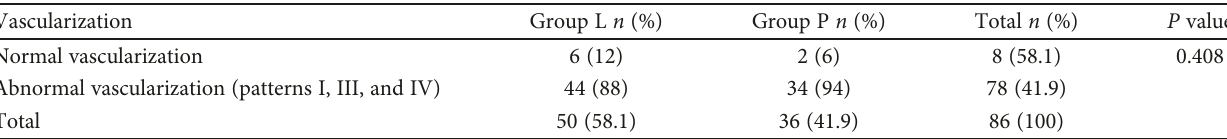
Table 4: Comparison between the proportions of patients with normal and abnormal thyroid volume between groups L and P at M2. Volume Group L n (%) P value Normal volume Abnormal volume (increased or reduced) Chi-squared test. Table 5: Comparison of the proportions of patients with normal and abnormal TVP between the L and the P groups at M2 . Vascularization Group L n (%) Group P n (%) Total n (%) P value Normal vascularization Abnormal vascularization (patterns I, III, and IV) Total 86 (100) Chi-squared